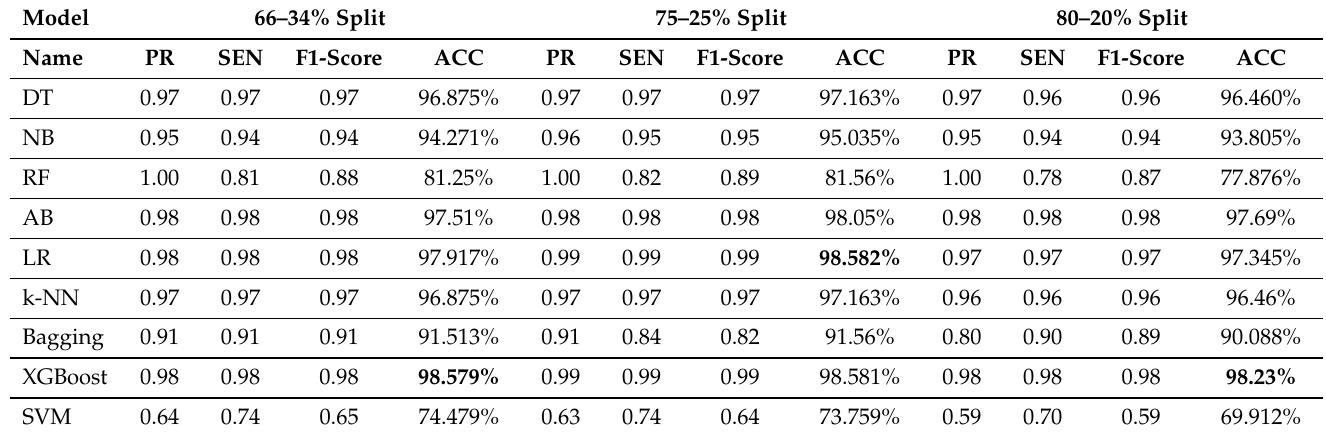
Table 7. Performance of ML models in experiment-2 (Splitting + No FS Applied).